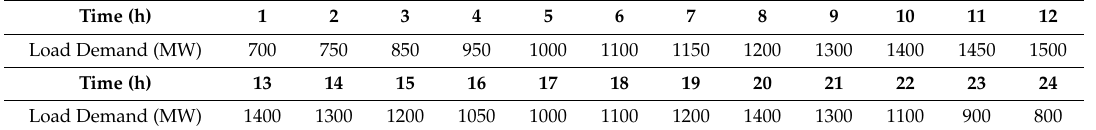
Table 3. Load demand for 24 h.